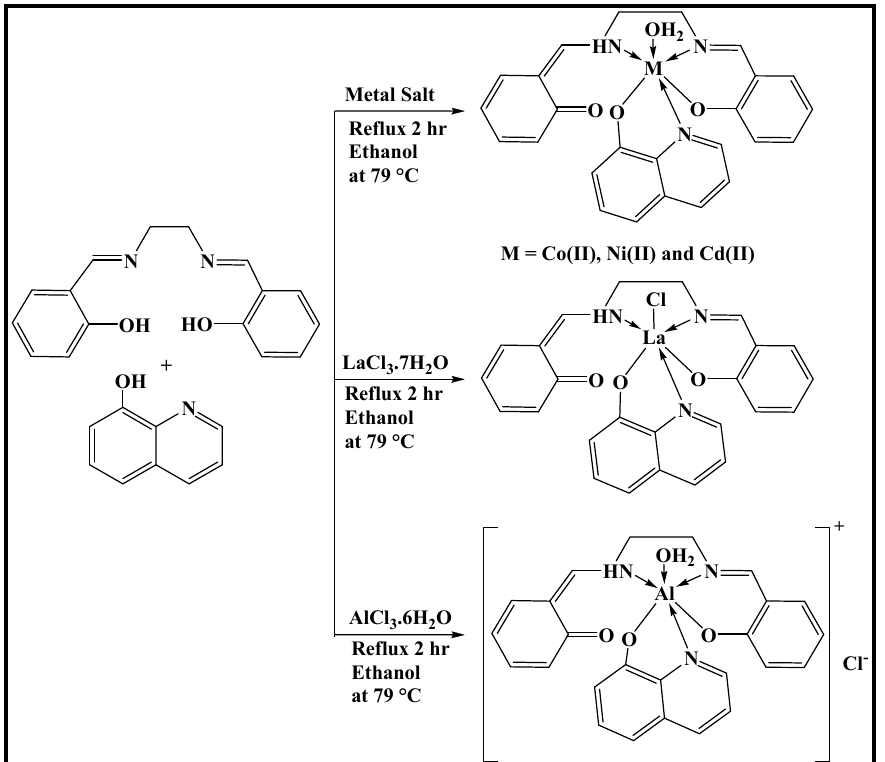
Scheme 1. Synthesis pathway for Co(II), Ni(II), Cd(II), Al(III), and La(III) of mixed salen ligand metal complexes with 8-hydroxyquinolone. Table 1. Analytical data for salen and salen/8-hydroxy quinoline mixed-ligand metal complexes of Co(II), Ni(II), Cd(II), Al(III), and La(III). Conductivity Compounds Molecular Molecular ◦ Color Yield % µ s M. P. Formula Weight